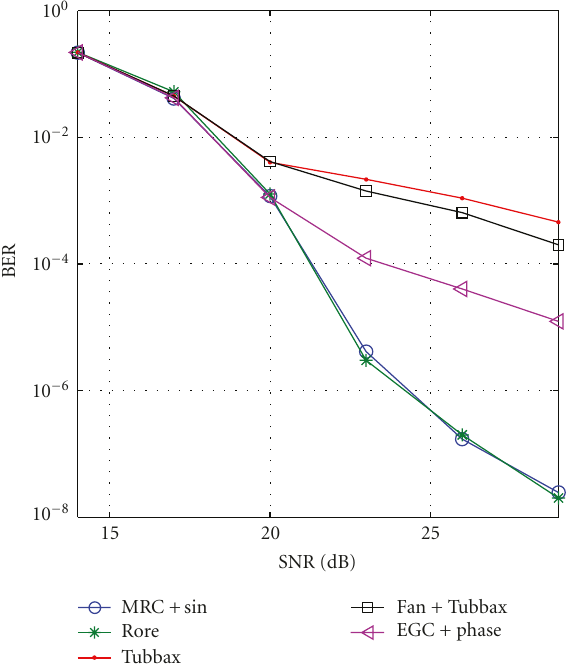
Figure 8: BER at di ff erent SNRs in coded system with random CFO in [0,1] and random I/Q mismatch which is uniformly distributed in [0,1] dB for gain mismatch and [0,4 ◦ ] for phase mismatch.